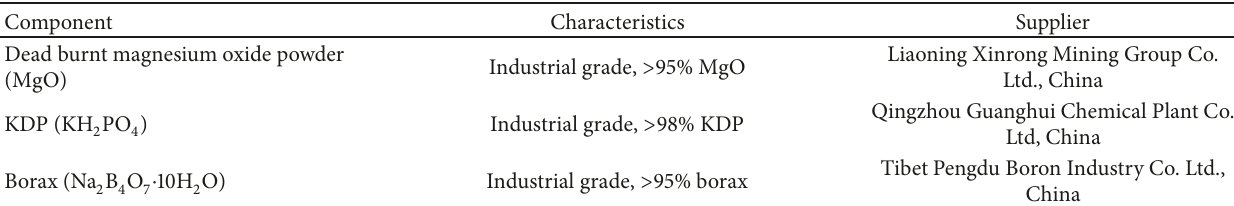
Table 1: Characteristics of raw materials.